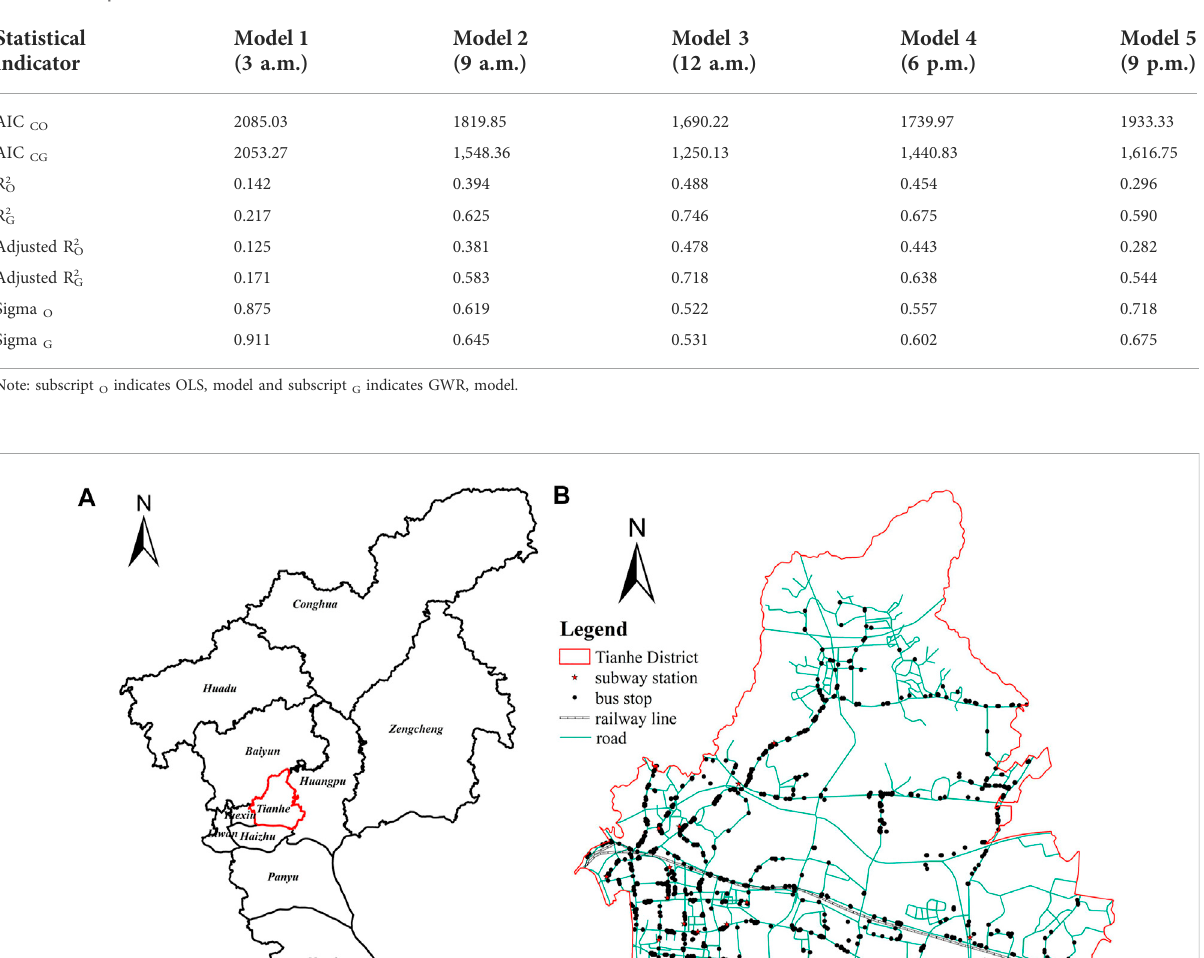
TABLE 3 Comparison of GWR and OLS models.